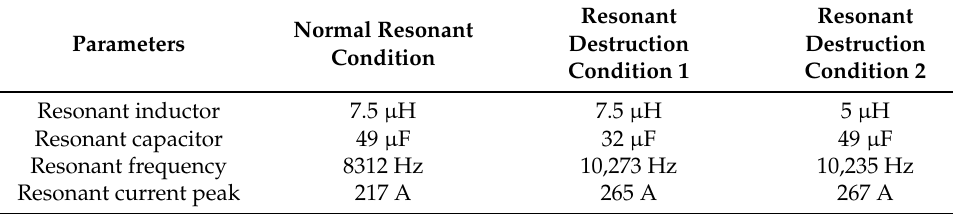
Table 4. Simulation results of resonant destruction